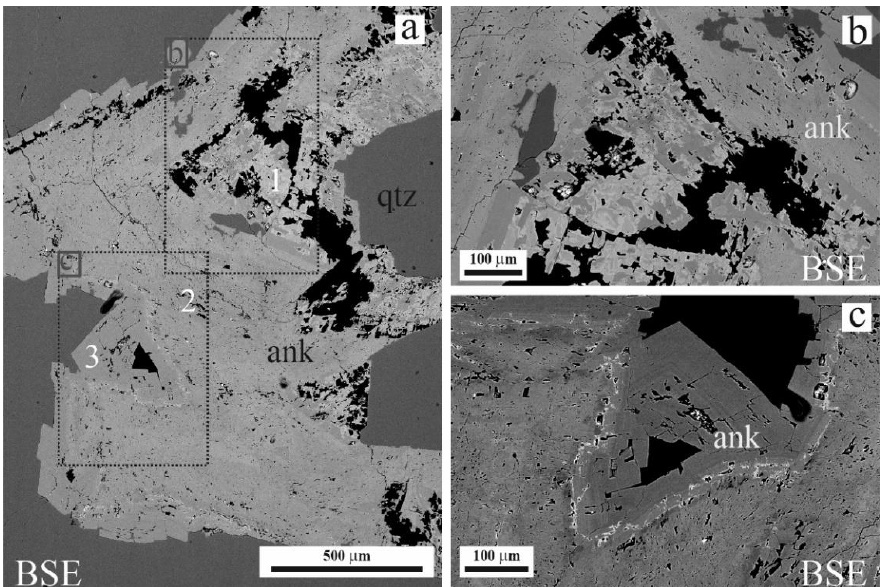
Figure 7. Back-scattered electron (BSE) images of zoned ankerite aggregate crystals in the El Dorado Au-Cu orebody (central Chile). Three zones are observed: (1) highly irregular zoned cores, with the highest Fe and Mn content; (2) porous weak zoned zone and overgrowth; with (3) weak oscillatory zonations and the lowest Fe and Mn content. Images ( b , c ) show details of the rectangle areas of image ( a ).